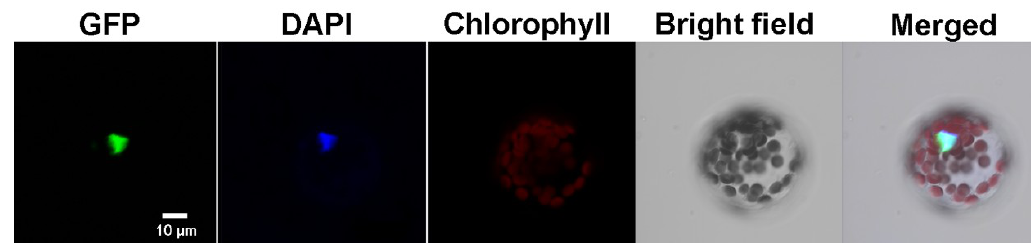
Figure 3. Subcellular localization of FaHsfC1b protein. FaHsfC1b‐eGFP fusion protein was localized in nucleus of Arabidopsis mesophyll protoplast. Bar = 10 µm.